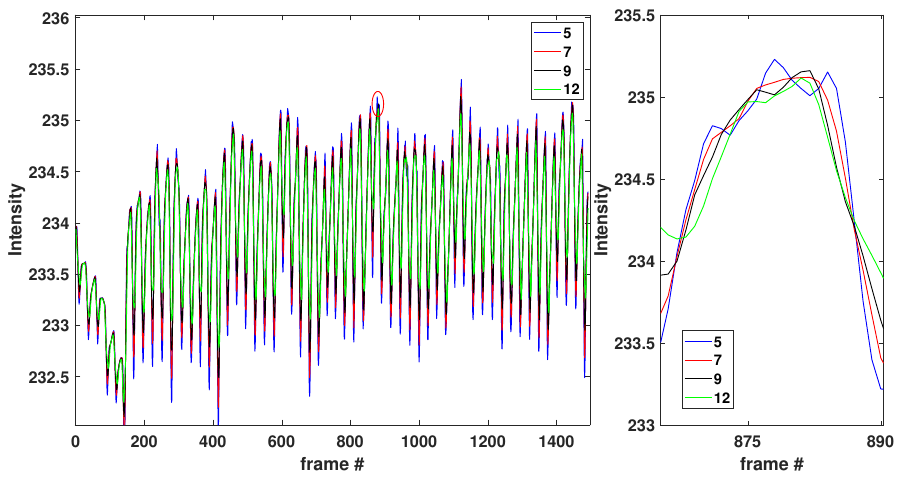
Figure 2. ( Left ): Mean intensity followed by a moving-average filter with several sliding window lengths vs. frame number. ( Right ): shows, in magnification, the region around the peak at frame